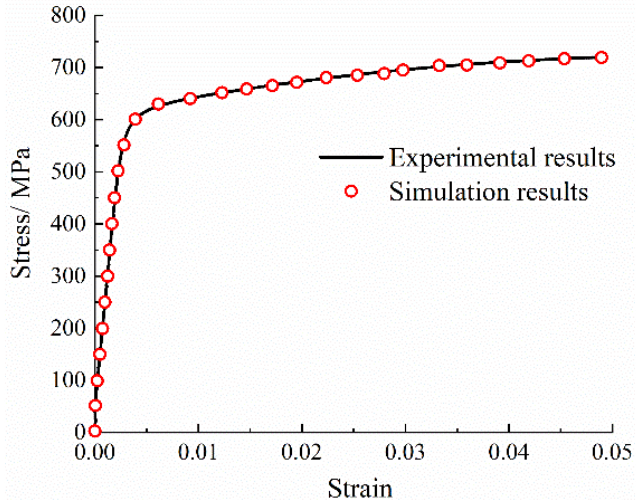
Figure 11. Comparison of simulation results with experimental data. Table 2. Errors between simulation results and experimental data.